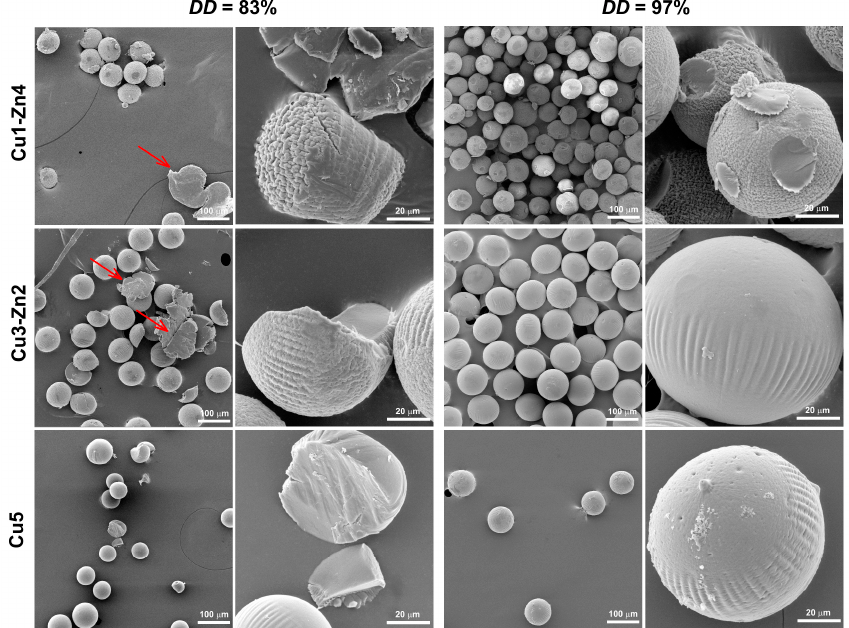
Figure 7. SEM micrographs of dry bimetallic chitosan microgels after 4 weeks of lysozyme degradation. The scale bars are 100 and 20 µm. Red arrows indicate microspheres’ disintegration.